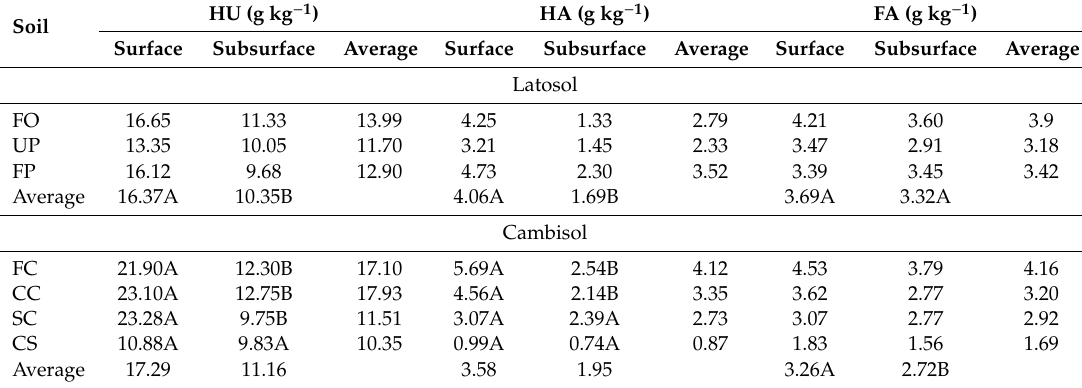
Table 3. Humic (HU), humic acid (HA), and fulvic acid (FA) for latosol (forest-FO, unfertilized pasture-UP, fertilized pasture-FP) and cambisol (forest-FC, pasture, coast cross-CC, sugarcane-SC and corn silage-CS) for the surface (0.0–0.1 m) and subsurface layer (0.1–0.2 m).